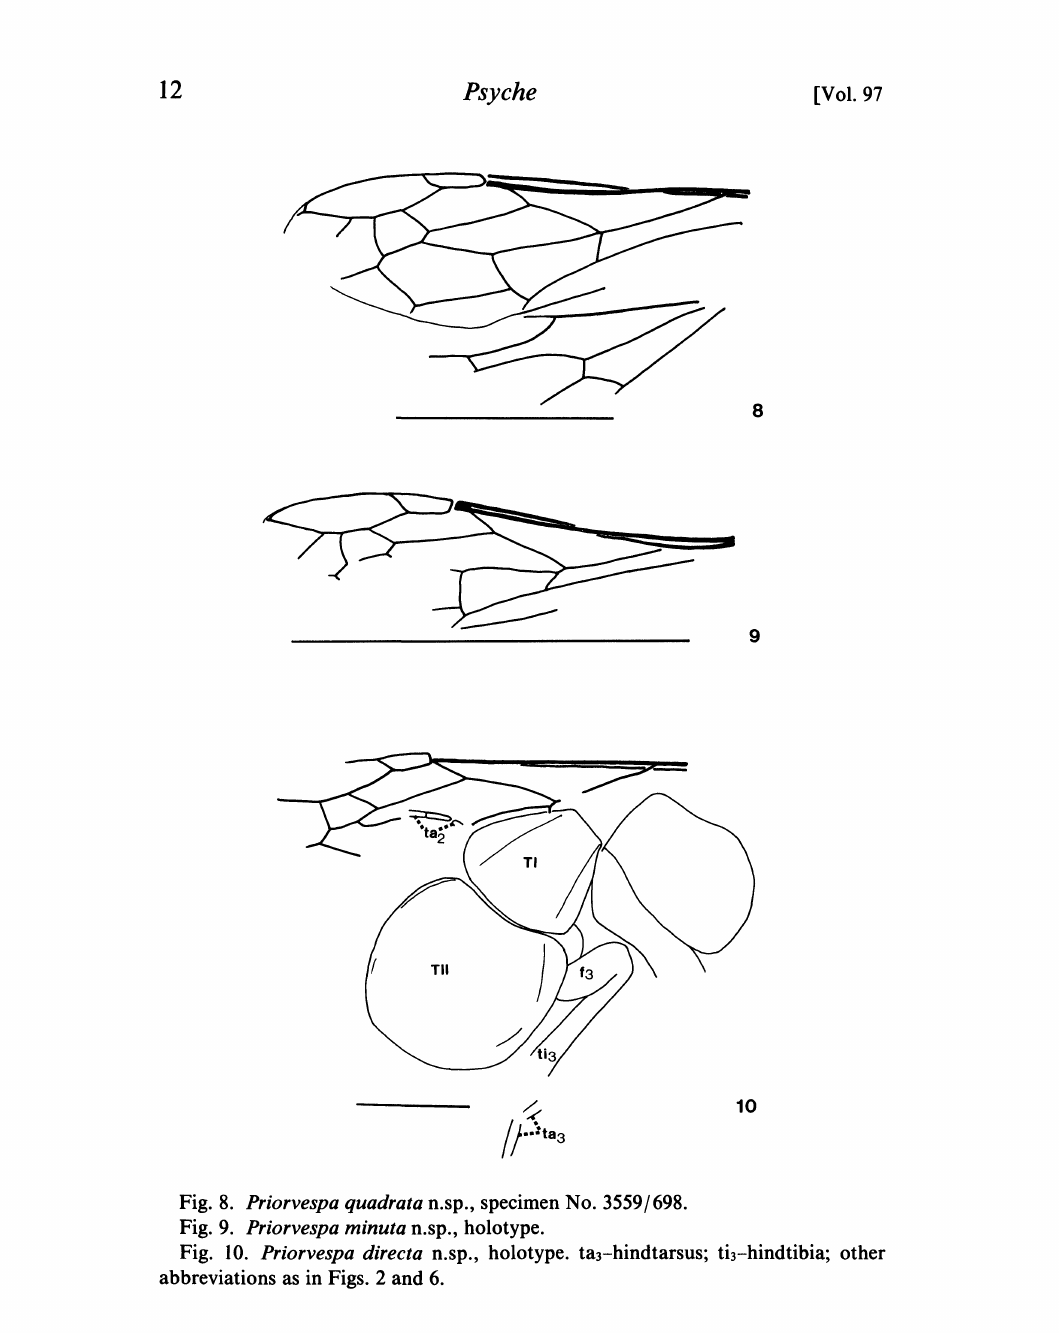
Fig. 8. Priorvespa quadrata n.sp., specimen No. 3559/698. Fig. 9. Priorvespa minuta n.sp., holotype. Fig. 10. Priorvespa directa n.sp., holotype, ta3-hindtarsus; ti3-hindtibia; other abbreviations as in Figs. 2 and